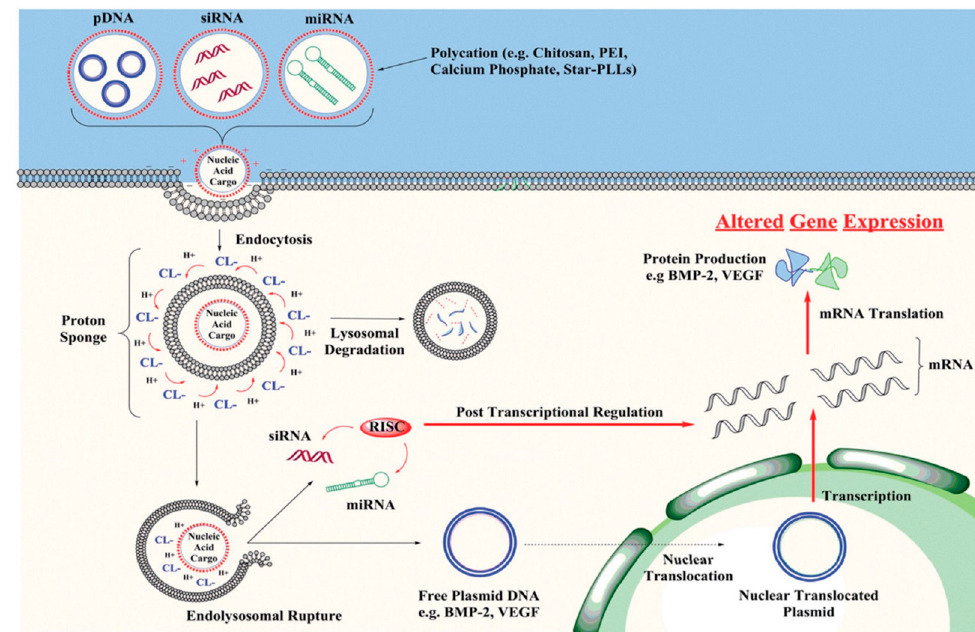
Figure 1. Non-viral vectors delivering pDNA, siRNA or miRNA into target cells by endocytosis or membrane fusion. Once inside the cells, most vector–nucleic acid complexes become trapped in an endosome. The nuclear acid cargo is then released to enter the nucleus for integration and expres- sion [13]. Copyright: Wiley Online Library